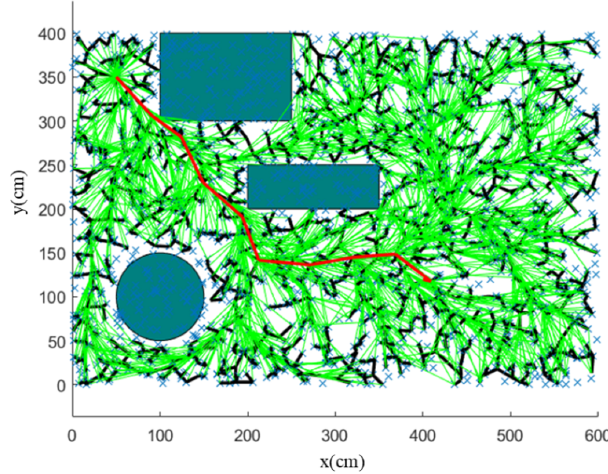
Figure 9. Projection trajectory of RRT in XOY plane of